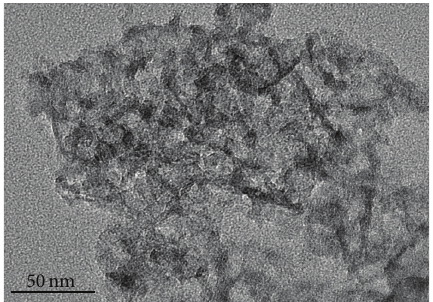
Figure 6: The typical TEM image of 1% Mo/Al-SSP catalyst.